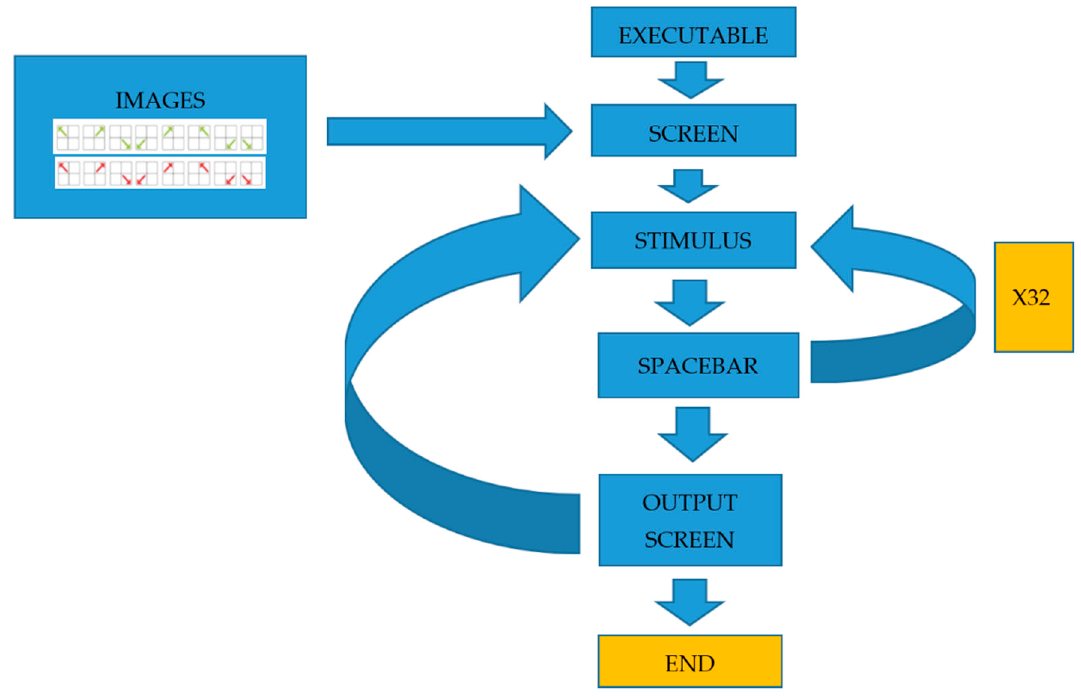
Figure 5. System flowchart.